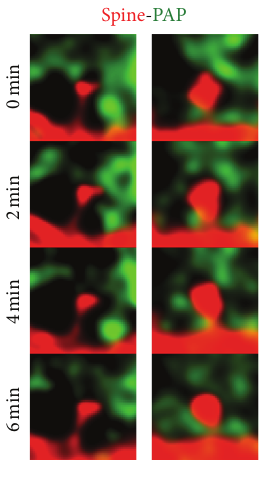
Figure 2: Perisynaptic astrocytic processes (PAPs) are motile. Z- stack projection of confocal images showing hippocampal CA1 dendritic spines (mcherryf, red) and PAPs (eGFPf, green) recorded in the stratum radiatum of organotypic hippocampal slice cultures. Neurons and astrocytes were virally infected with membrane tar- geted fluorescent proteins by injection. The labeled structures were monitored every 2min to reveal PAP movements around spines. Square size: 3 × 3 𝜇 m (original